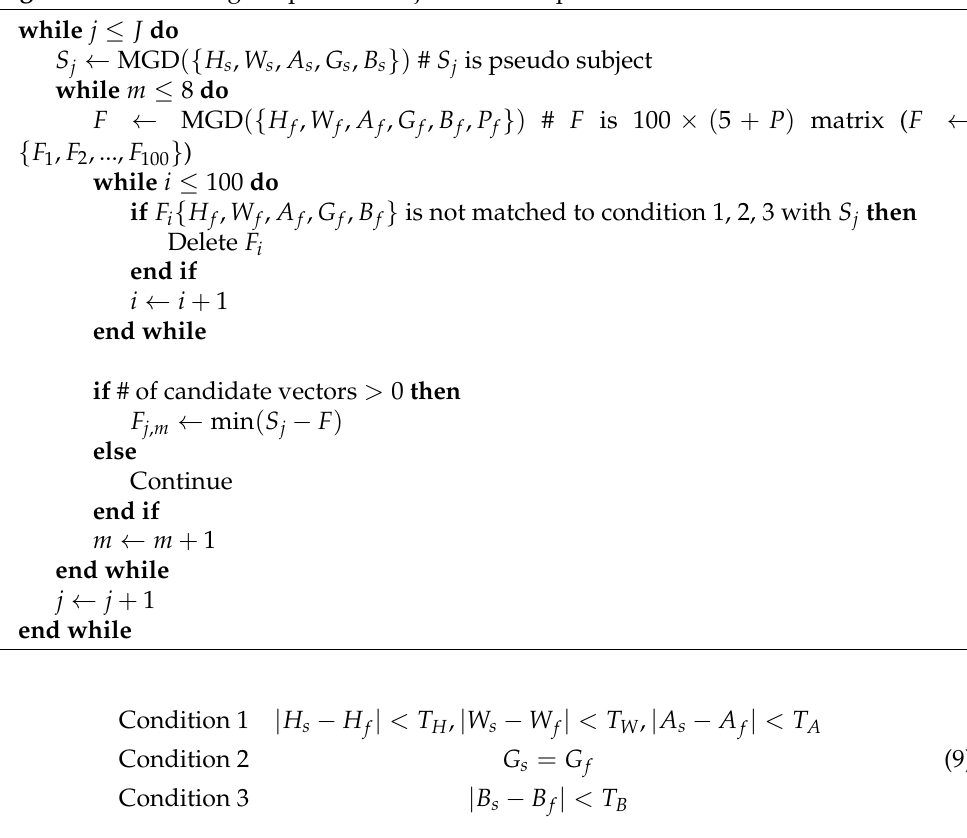
Algorithm 1 Matching the pseudo subject with the pseudo